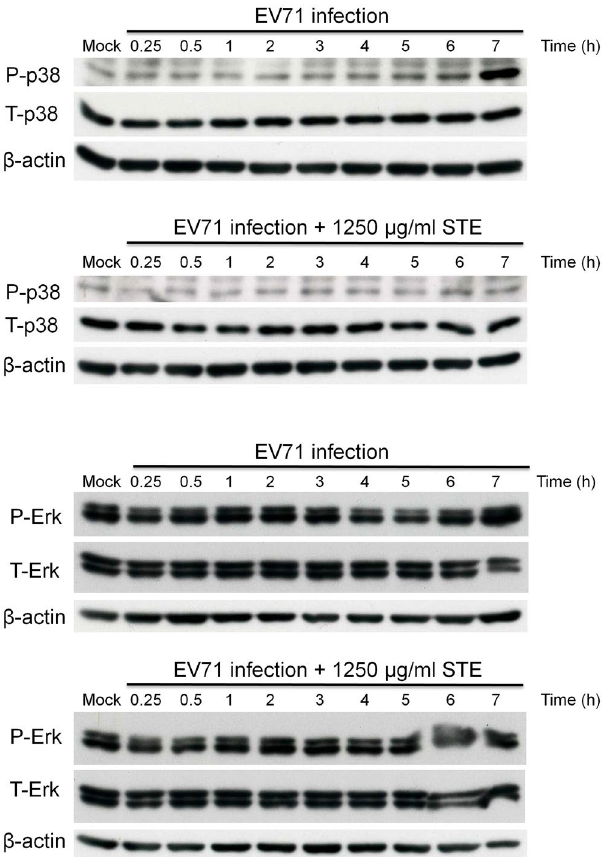
Figure 4. STE inhibits EV71-induced p38 kinase phosphorylation. RD cells were mock- or infected with BrCr at m. o. i. of 20 for 1 h, and subsequently treated with 1250 µ g/ml STE. The treated cells were harvested at 0.25, 0.5, 1, 2, 3, 4, 5, 6, and 7 h p. i. Levels of p38 kinase and Erk1/2, and the corresponding phosphorylated forms (P-p38 and P-Erk) were examined by western blotting. The blot was stripped, and analyzed with antibody to β -actin. The cropped images of the blots are shown. A representative experiment out of three is